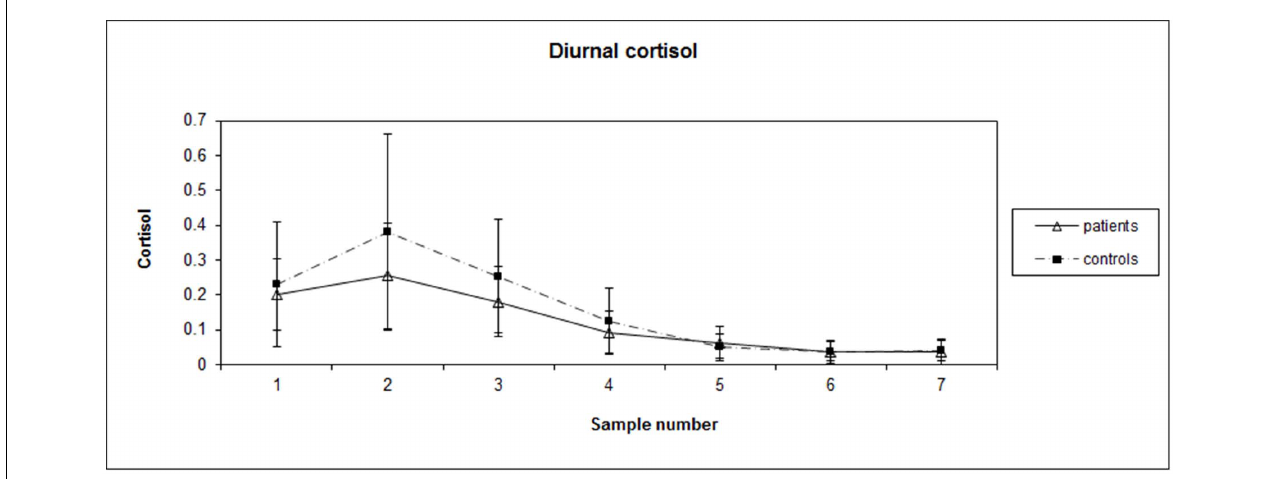
FIGURE 1 | Diurnal cortisol rhythms for breast cancer patients and matched controls.